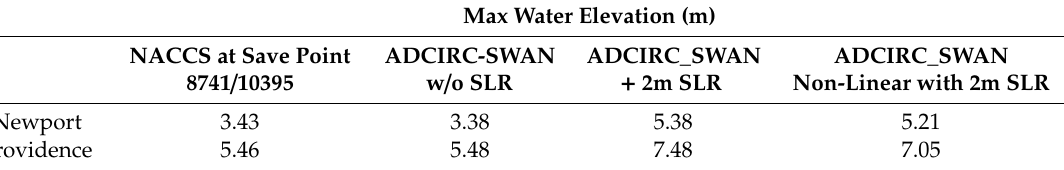
Table 1. Maximum water level at Newport and Providence from NACCS storm #492 for the save point closest to these locations (NACCS save point #8741-Newport, #10395-Providence) based on the original simulations, as a result of the application of ADCIRC-SWAN high-resolution model (Torres et al., 2018) [15] without SLR, with 2-m SLR simply added, and with 2-m SLR added to the initial bathymetry and nonlinear simulations performed.